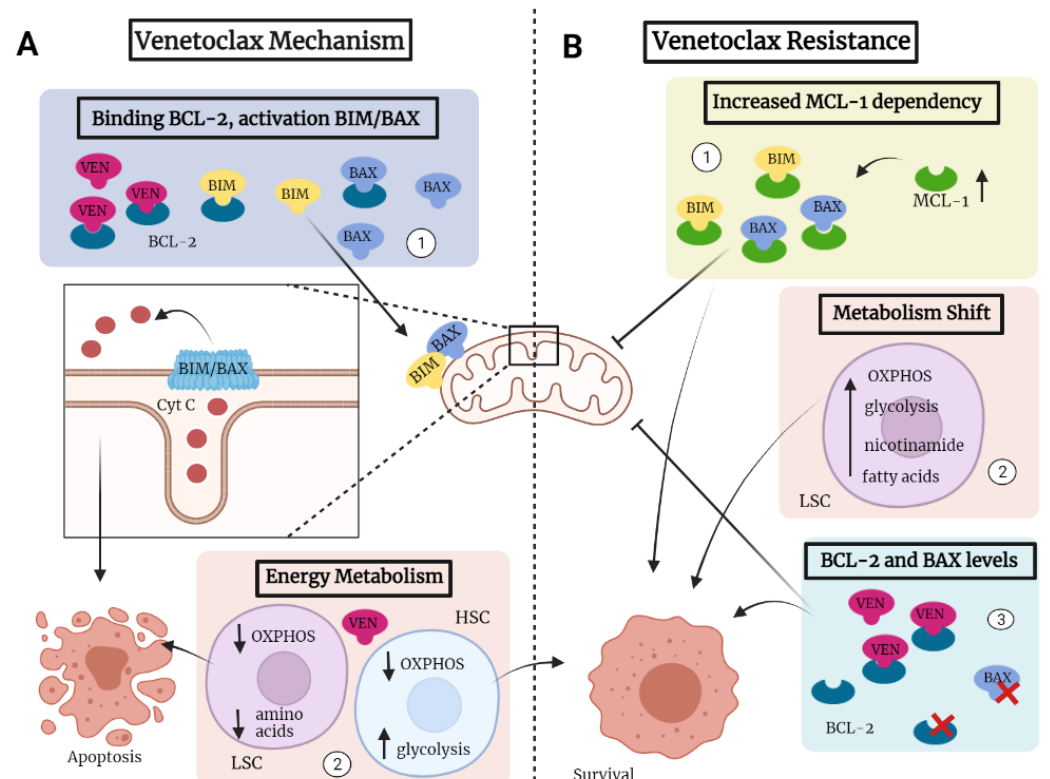
Figure 1. Mechanism of action and resistance in venetoclax treatment. ( A ) Mechanism of action: 1. Venetoclax prevents the inhibitory interaction between BCL-2 and the pro-apoptotic proteins BAX and BIM. BAX and BIM increase mitochondrial outer membrane permeability, releasing Cyt C and initiating apoptosis. 2. Venetoclax reduces OXPHOS and amino acid uptake in LSC, normal HSC compensate through increased glycolysis. ( B ) Mechanism of venetoclax resistance: 1. Increased MCL-1 dependency prevents mitochondrial localization of BIM and BAX, 2. Other energy sources than OXPHOS are used for energy metabolism. 3. A decrease in or mutations in BCL-2 prevent venetoclax from binding, and mutations in BAX inhibit mitochondrial localization. Abbreviations: Cyt C; cytochrome C, HSC; hematopoietic stem cell, LSC; leukemic stem cell, OXPHOS; oxidative phosphorylation, VEN; venetoclax.